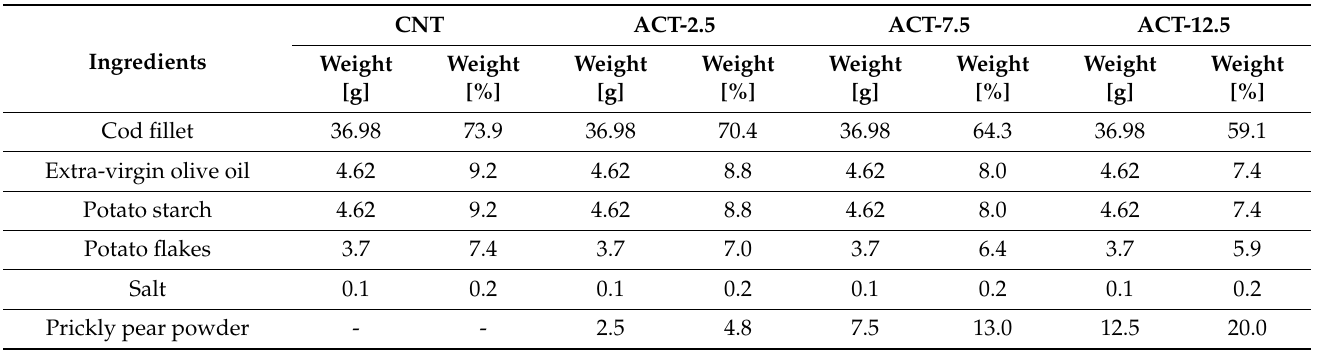
Table 1. Formulation of the cod fish burgers with and without prickly pear powder